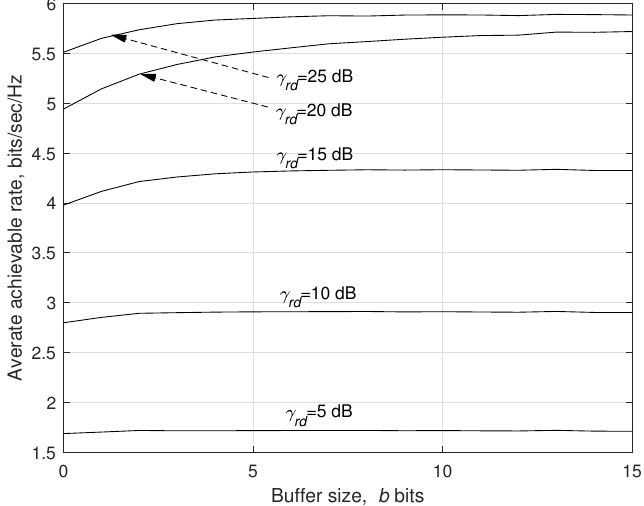
Figure 3. Average achievable rate R B in Equation (7) over the buffer size b bits when γ sd = 20